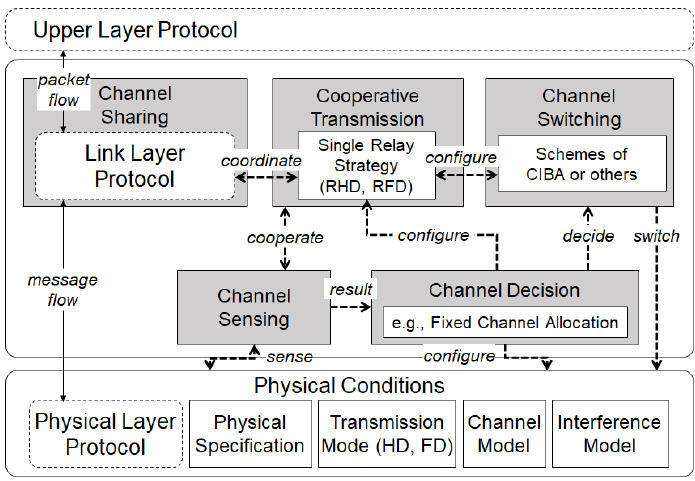
Figure 2. Multi-channel allocation management framework in wireless system